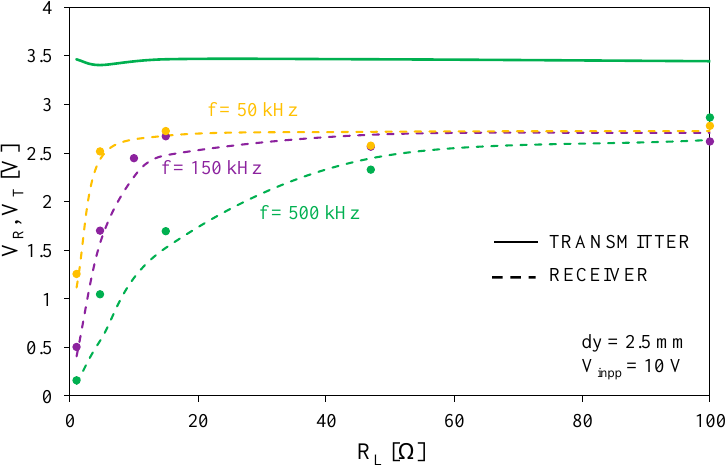
Figure 12. Dependence of voltages on the transmitting and receiving coils on load resistance at selected values of frequency.